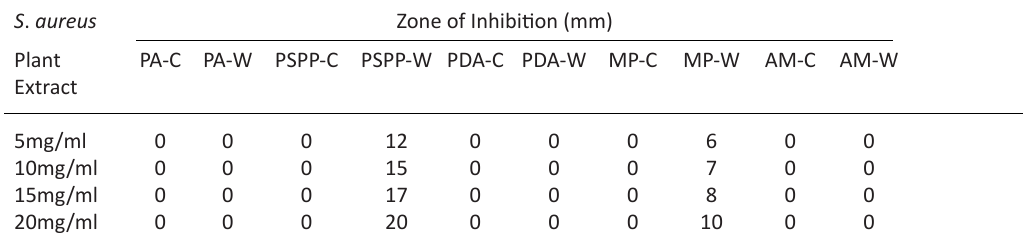
Table 4. Zone of Inhibition by plant extracts against Staphylococcus aureus S . aureus